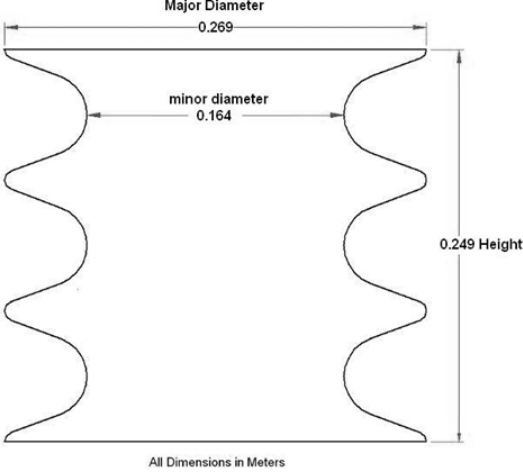
Fluids 2020 , 5 , 25 Figure 2. Schematic of corrugated cylinder model. All dimensions are in meters.